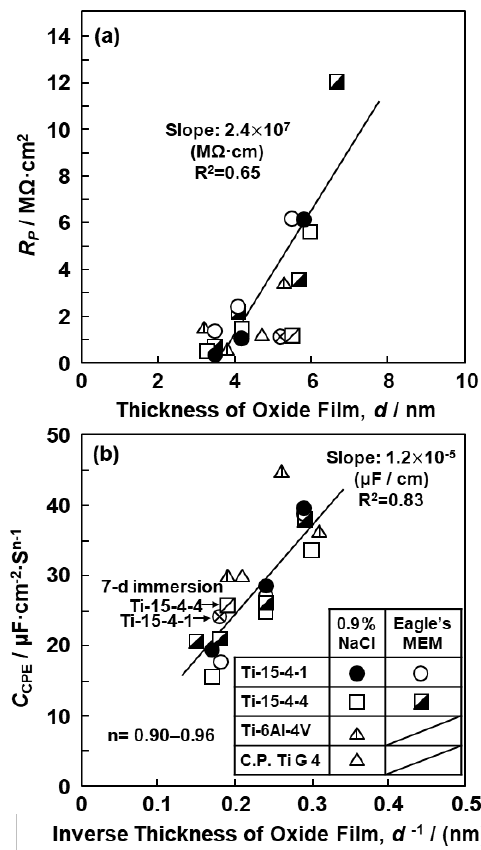
Figure 9. ( a ) Plot of oxide film resistance (R P ) of Ti–15Zr–4Nb–1Ta, Ti–15Zr–4Nb–4Ta, Ti–6Al–4V, and C.P.-Ti G-4 vs. the oxide film thickness (d) obtained by FE-TEM. ( b ) Plot of capacitance (C CPE ) of oxide films vs. 1 / d obtained by anodic polarization test or by 7-d immersion test in 0.9% NaCl and Eagle’s MEM solutions at 37 °C.